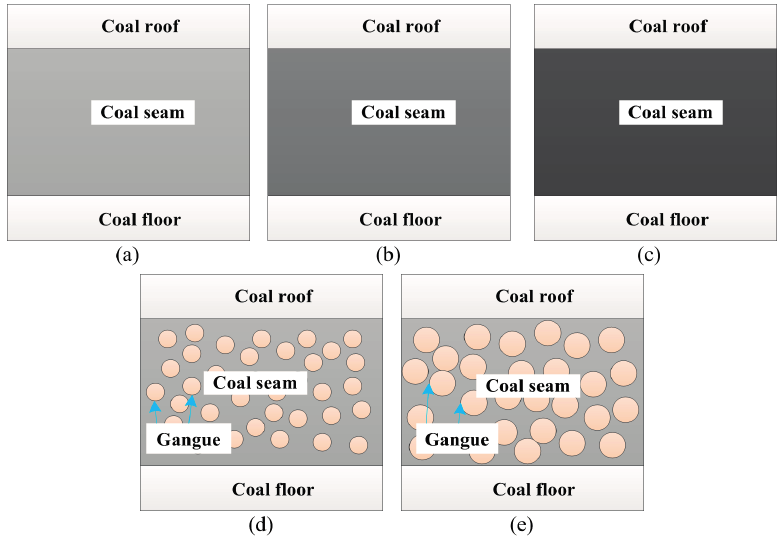
Figure 2. Different geological conditions of coal seam: ( a ) f = 2; ( b ) f = 3; ( c ) f = 4; ( d ) f = 5; ( e ) f =